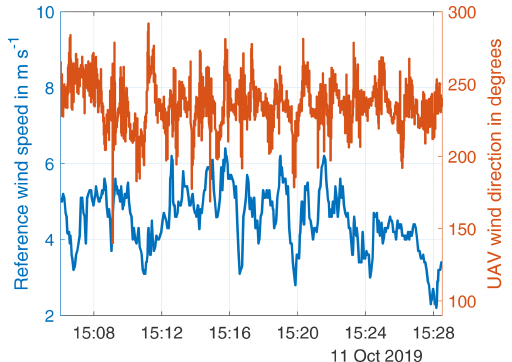
Figure 17. Wind speed and wind direction during the measurement flight. Wind speed was measured by the reference cup anemome- ter on top of the nacelle u ref . Wind speed varied between 2.1 and 6.5ms − 1 . No reference sensor was available for wind direction; hence, the figure shows wind direction as measured by the UAV (in- cluding all variations introduced by the wind turbine rotor). Wind direction varied between 140 and 290 ◦ .